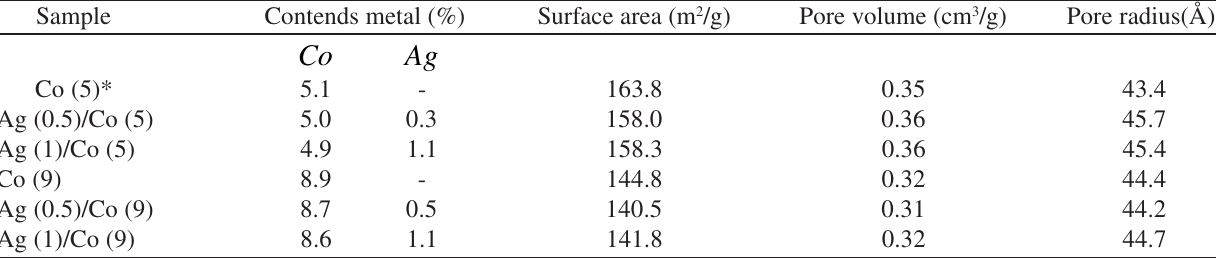
Table 1. Composition and surface area, pore volume and pore radius of the catalysts.